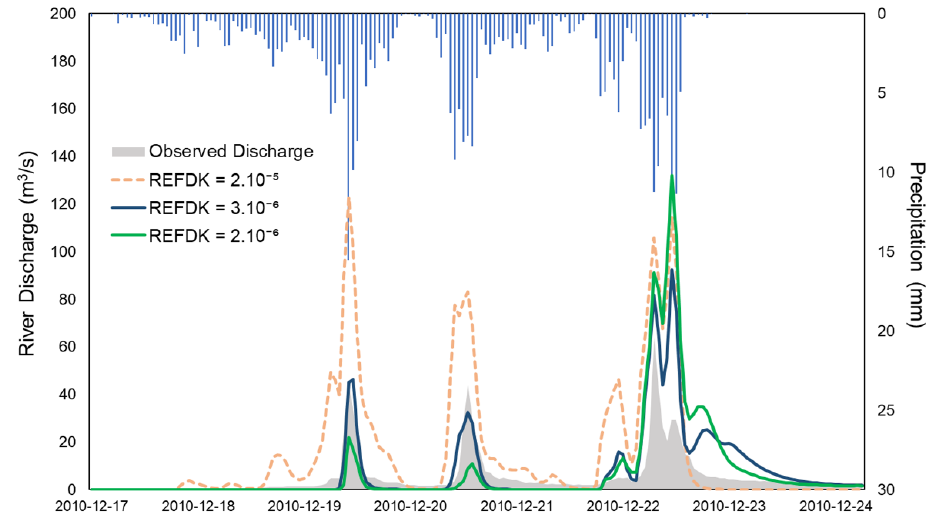
Figure 5. Simulated hydrographs at Arroyo Seco with sensitivity tests of REFDK with REFKDT = 0.4.